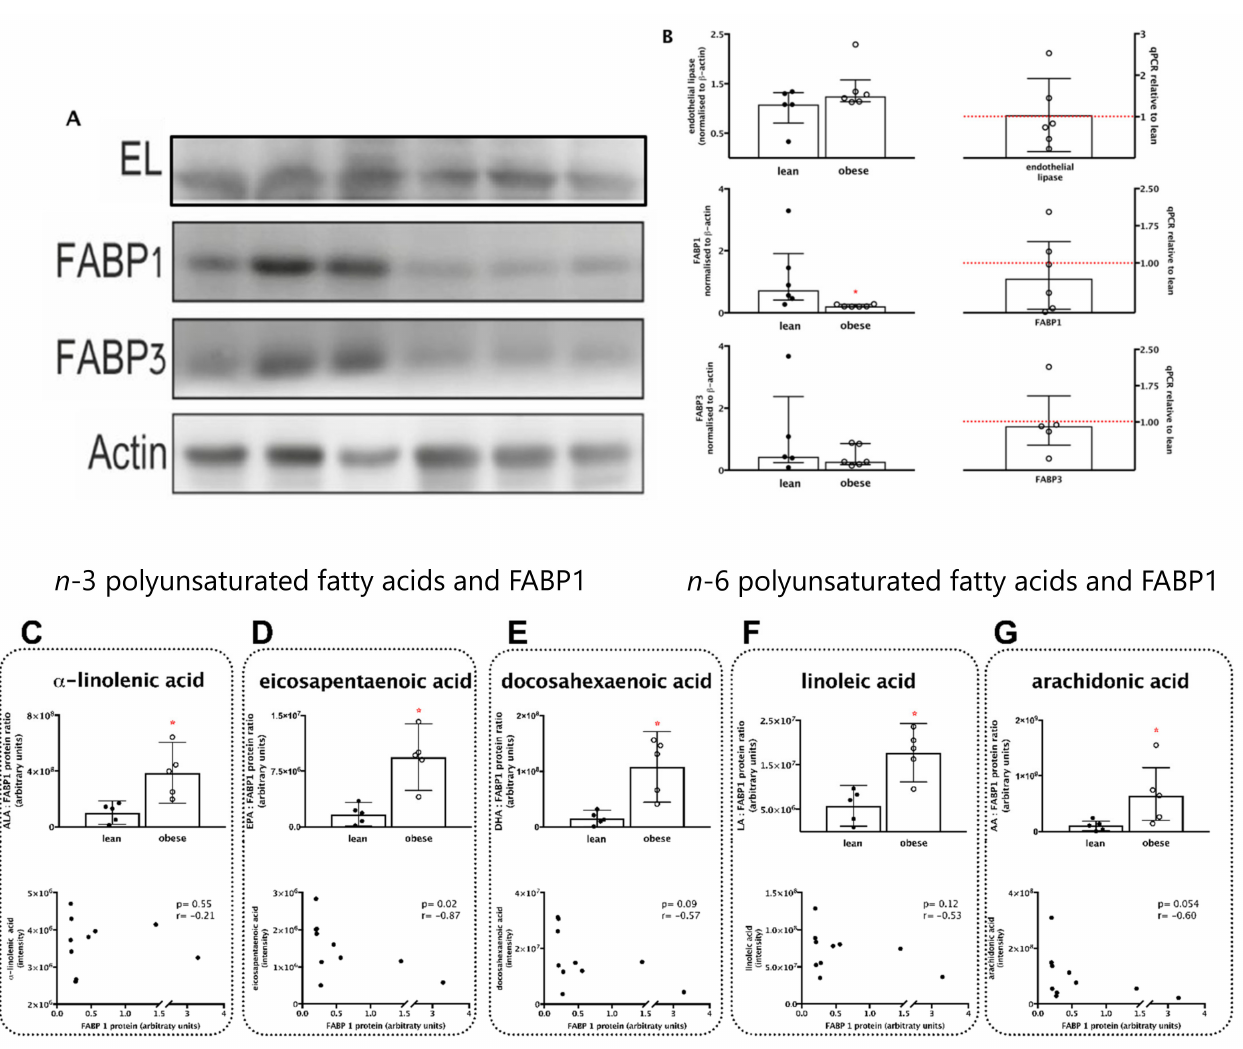
Figure 2. Fatty acid transporter protein FABP1 is decreased and negatively associates with long-chain polyunsaturated fatty acids in placentas from women with pre-gestational obesity. Placentas from lean ( • ) and from obese ( were compared according to placental fatty acid transporter proteins endothelial lipase, FABP1, and FABP3 at the protein and transcript levels ( A , B ). The ratio of polyunsaturated fatty acids to FABP1 and the respective Spearman correlations were calculated for the n -3 fatty acids α -linolenic ( C ), eicosapentaenoic ( D ), and docosahexaenoic ( E ), and for the n -6 fatty acids linoleic ( F ) and arachidonic ( G ), to investigate possible associations between alterations in FABP1 and long-chain fatty acid contents as a function of maternal pre-gestational obesity. * Significantly different from the lean group; p < 0.05 (Mann–Whitney